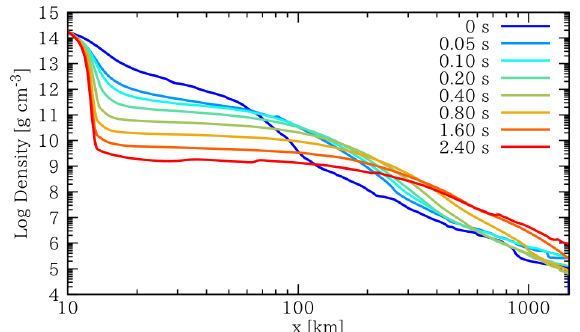
Figure 6. Density profiles on the equatorial plane at different time slices t ∼ 0, 0.05, 0.1, 0.2, 0.4, 0.8, 1.6, and 2.4 s. The torus gradually expands with time and its density decreases. This is due to viscous angular momentum transport. Even one second after merger the SMNS resides in a low density torus, in contrast to its inherent nuclear densities. (Reprinted from [108]. c (cid:13) AAS. Reproduced with